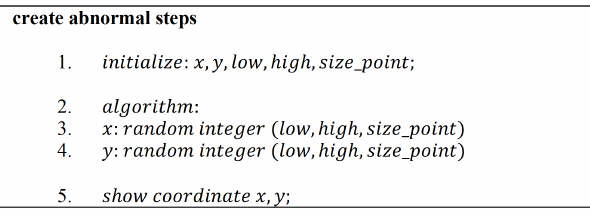
Figure 3. Algorithm for generating abnormal movements.